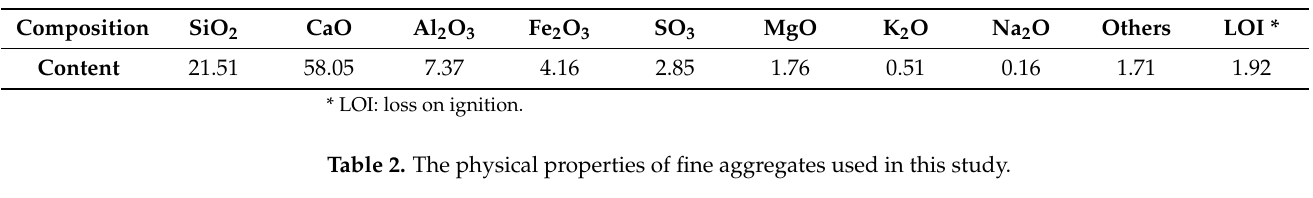
Table 1. Chemical compositions of P.O. 42.5 ordinary Portland cement (wt.%).